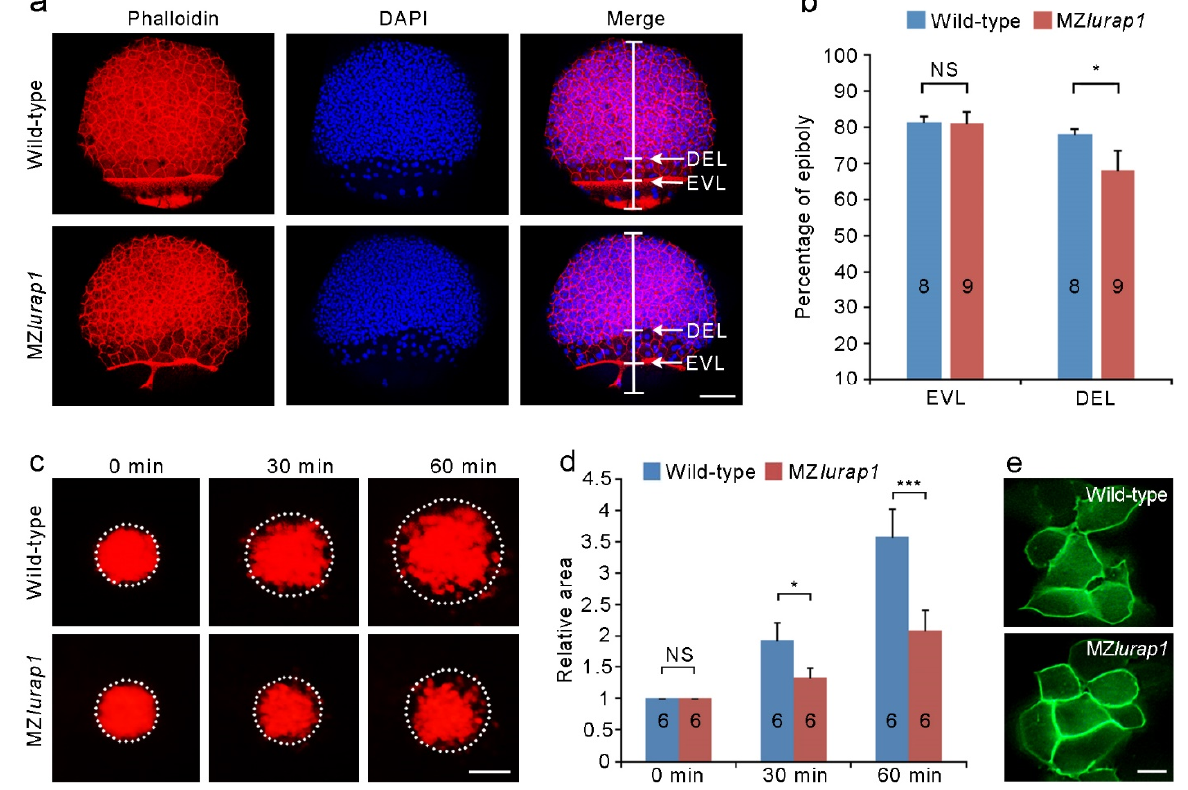
Figure 3. Delayed epibloy progression and reduced spreading capacity of DEL cells in MZ lurap1 mutant embryos. ( a ) Phalloidin and DAPI staining of wild-type and MZ lurap1 mutant embryos at 80% epiboly. Scale bar: 100 µ m. ( b ) Statistical analysis of the extent of vegetal movements of the EVL and the DEL in wild-type and MZ lurap1 mutant embryos. The percentage of epiboly was determined as the distance from the animal pole to the front of the EVL or the DEL margin with respect to the distance between the animal pole and the vegetal pole. Data were collected from 8 to 9 wild-type or MZ lurap1 mutant embryos. Bar represents the mean value ± s.d. (NS, not significant; *, p < 0.05). ( c ) UV-induced green to red fluorescence conversion of Kaede GFP in the animal pole region at 4 hpf. Areas within dashed circles reflect the extent of DEL cell spreading at indicated times. Scale bar: 100 µ m. ( d ) Statistical analysis of the extent of cell spreading. Data were collected from 6 embryos for each condition in three independent experiments, and the area initially occupied by labeled cells in wild-type embryos is normalized as 1. Bars represent the mean value ± s.d. (NS, not significant; *, p < 0.05; ***, p < 0.001). ( e ) Representative images of mGFP-labeled wild-type cells or MZ lurap1 mutant cells transplanted to unlabeled wild-type recipients. Scale bar: 10 µ